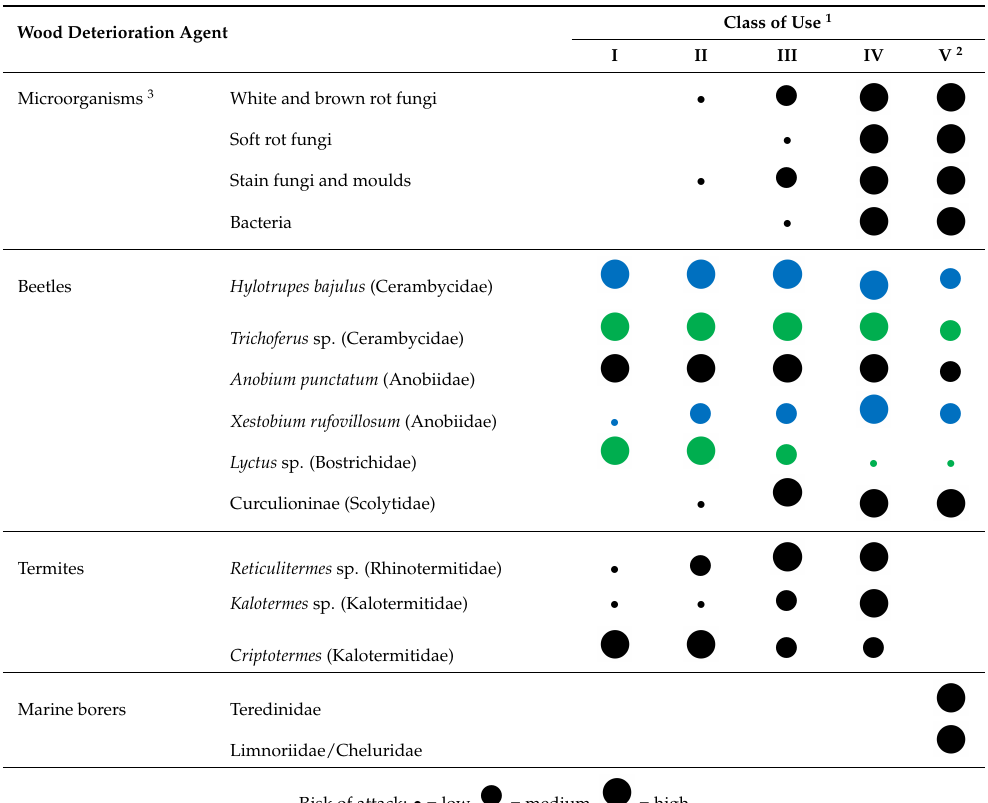
Table 1. Frequent biological agents deteriorating wood in service in